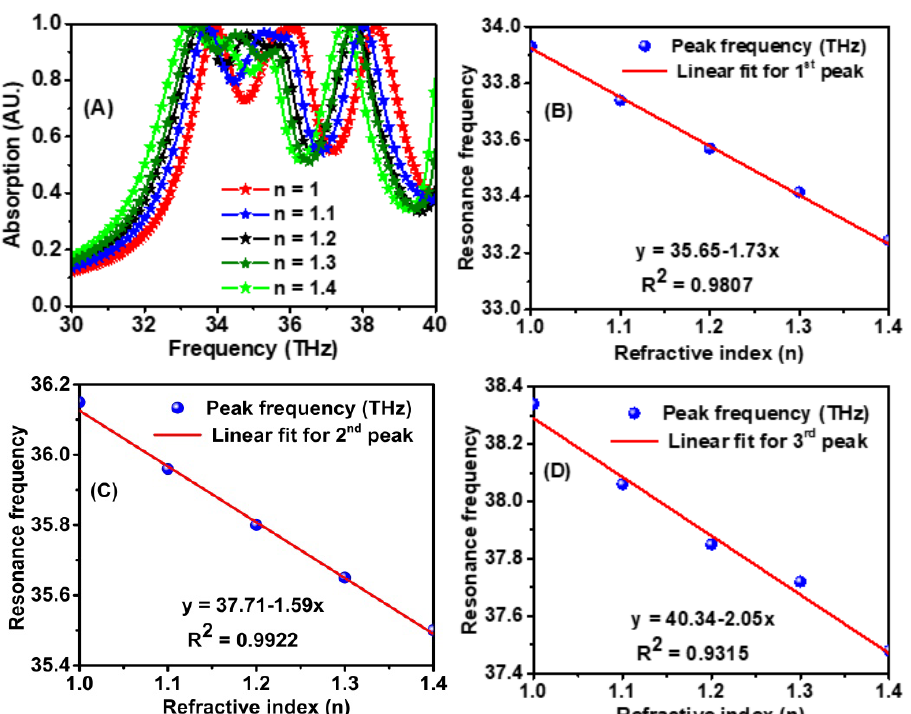
Figure 7. ( A ) Absorption spectrum dependence on the variation of the refractive index of the sur- rounding, and ( B – D ) shows the resonance frequency peak with the linear fit of the three frequencies versus the refractive index.